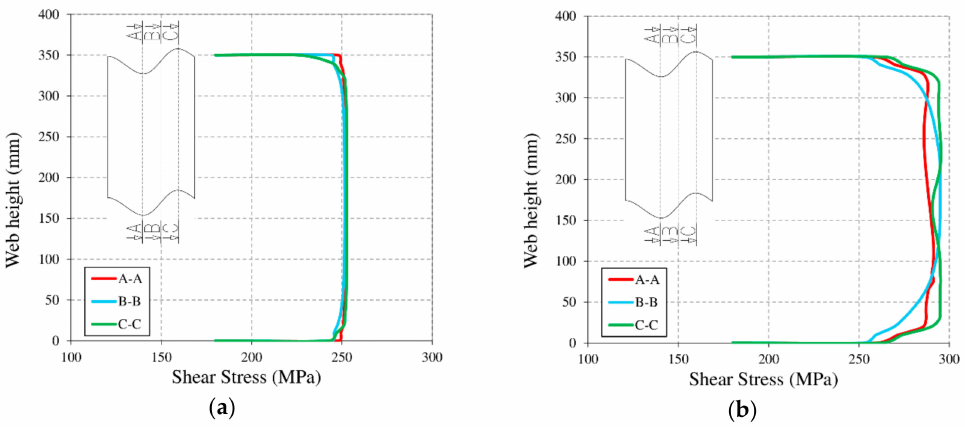
Figure 14. Typical σ 12 shear stress distribution on the corrugated web at three di ff erent corrugation cross sections: ( a ) before buckling; ( b ) after